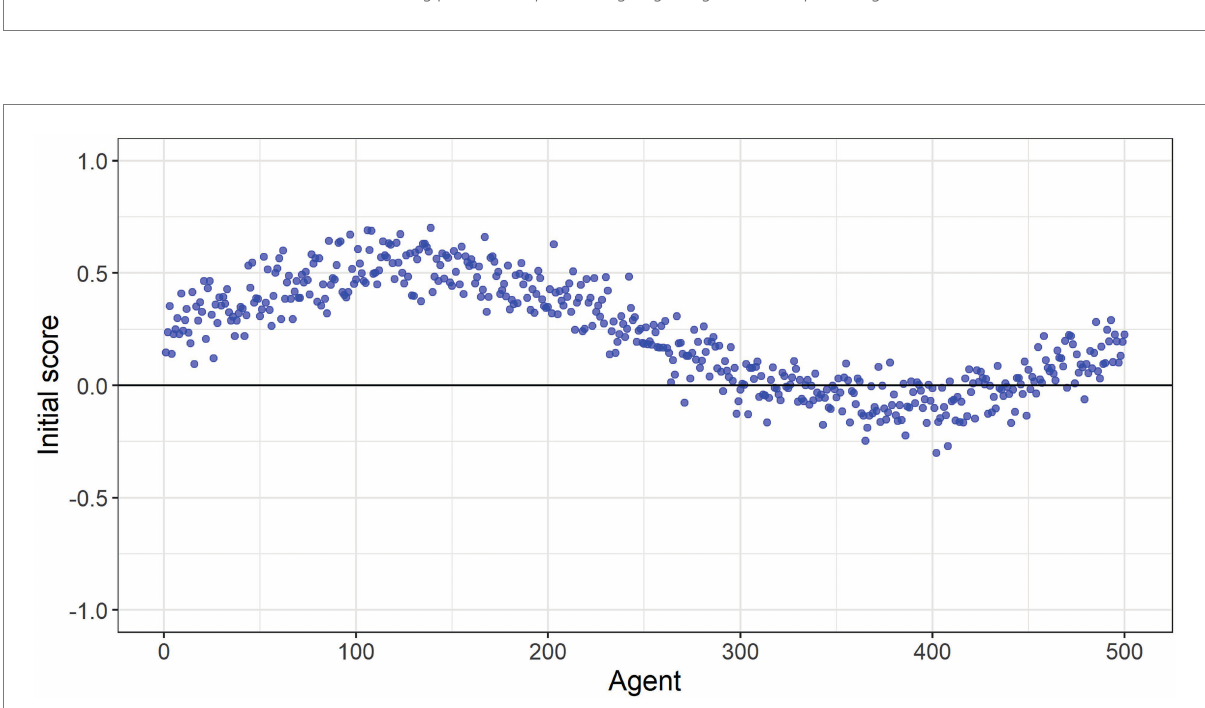
FIGURE 3 The small world model with N = 8, k = 4 and rewiring probabilities p = 0 (left), giving a ring lattice, and p = 0.2 (right).